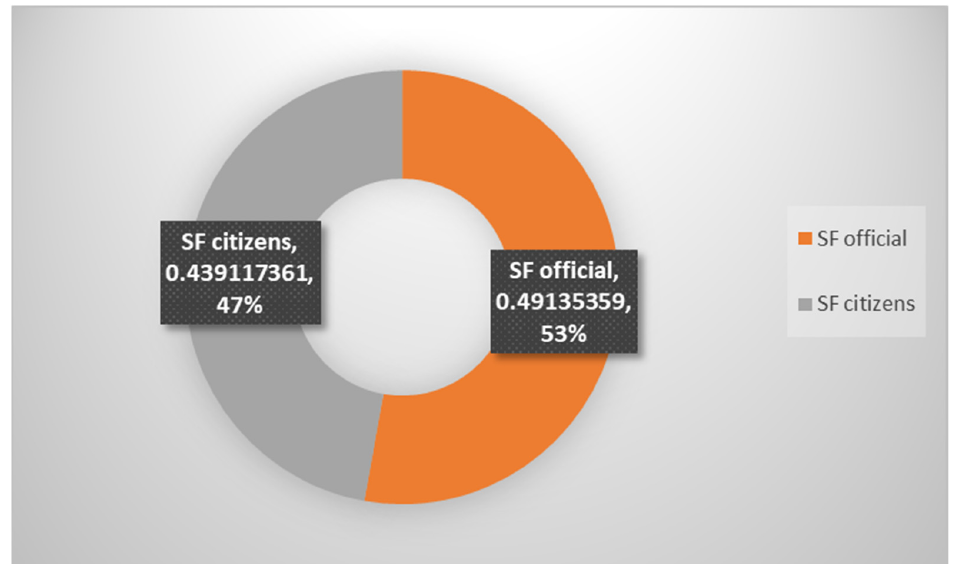
Figure 10. The share of the supportability factor resulting from the calculation of the two coefficients, from public sources and from citizen sources.